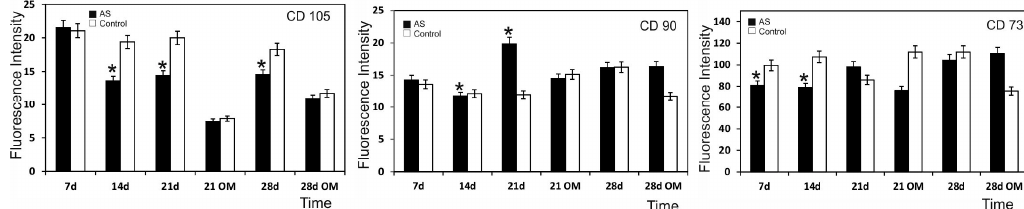
Figure 7. CD105, CD90 and CD73 expressions of the cells seeded on the biomaterial compared to the control. Data represent the fluorescence level. The experiment was performed in triplicate. * denotes a significant difference at p < 0.05 between the cells cultivated on the material and the control at the same time.